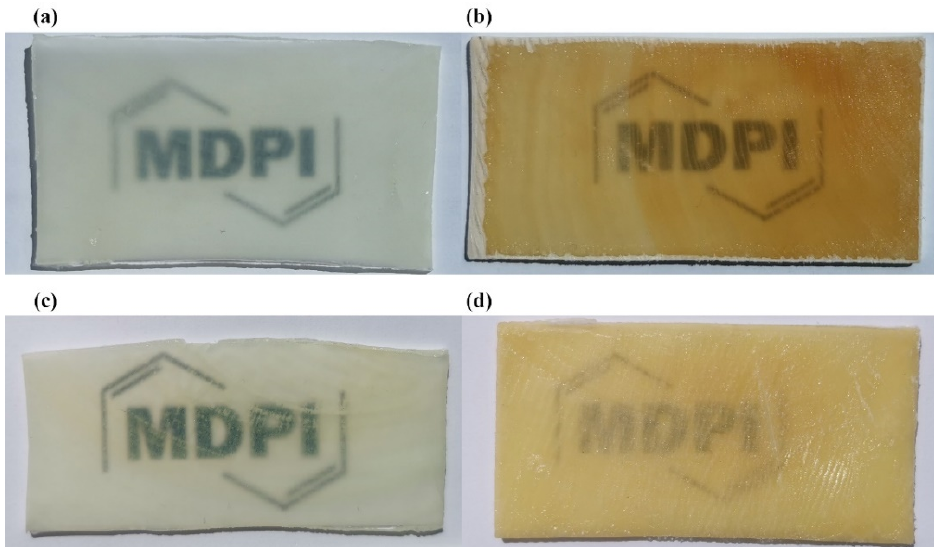
Figure 4. Change of transmittance and colour: W+EMA ( a ) before UV-C irradiation; ( b ) after 35 days of UV-C irradiation; W+MMA ( c ) before UV-C irradiation; ( d ) after 35 days of UV-C irradiation (Source of logo: https://www.mdpi.com/journal/polymers, accessed on 28 May 2021).